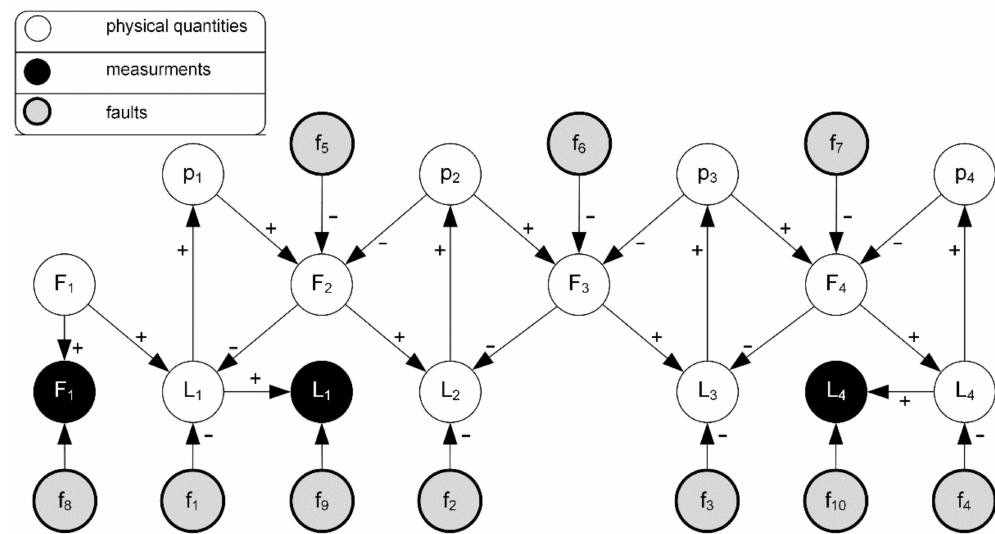
Figure 4. GP graph of the process, including fault influence on process variables.